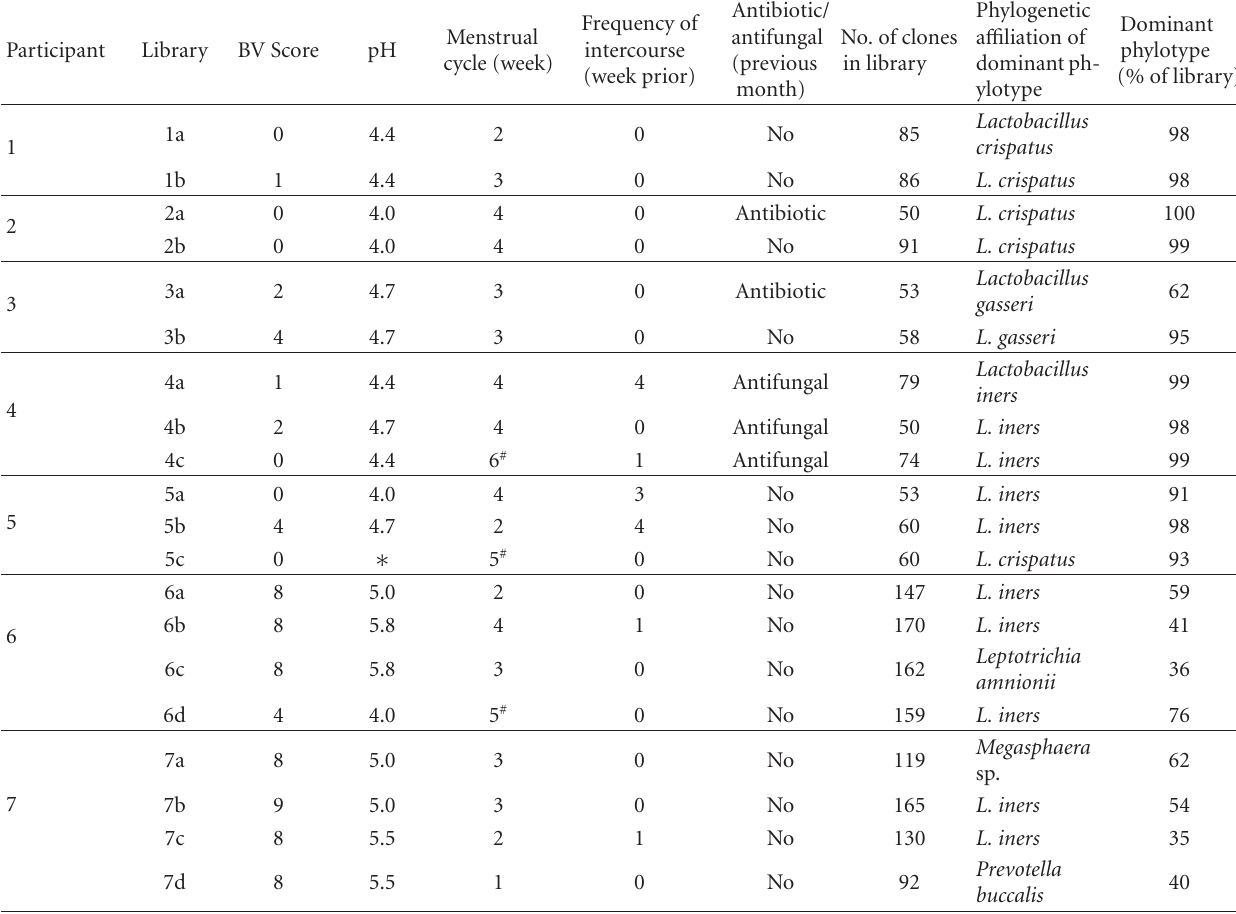
Table 1: Relevant clinical and 16S rRNA gene clone library information for the seven participants in this study.